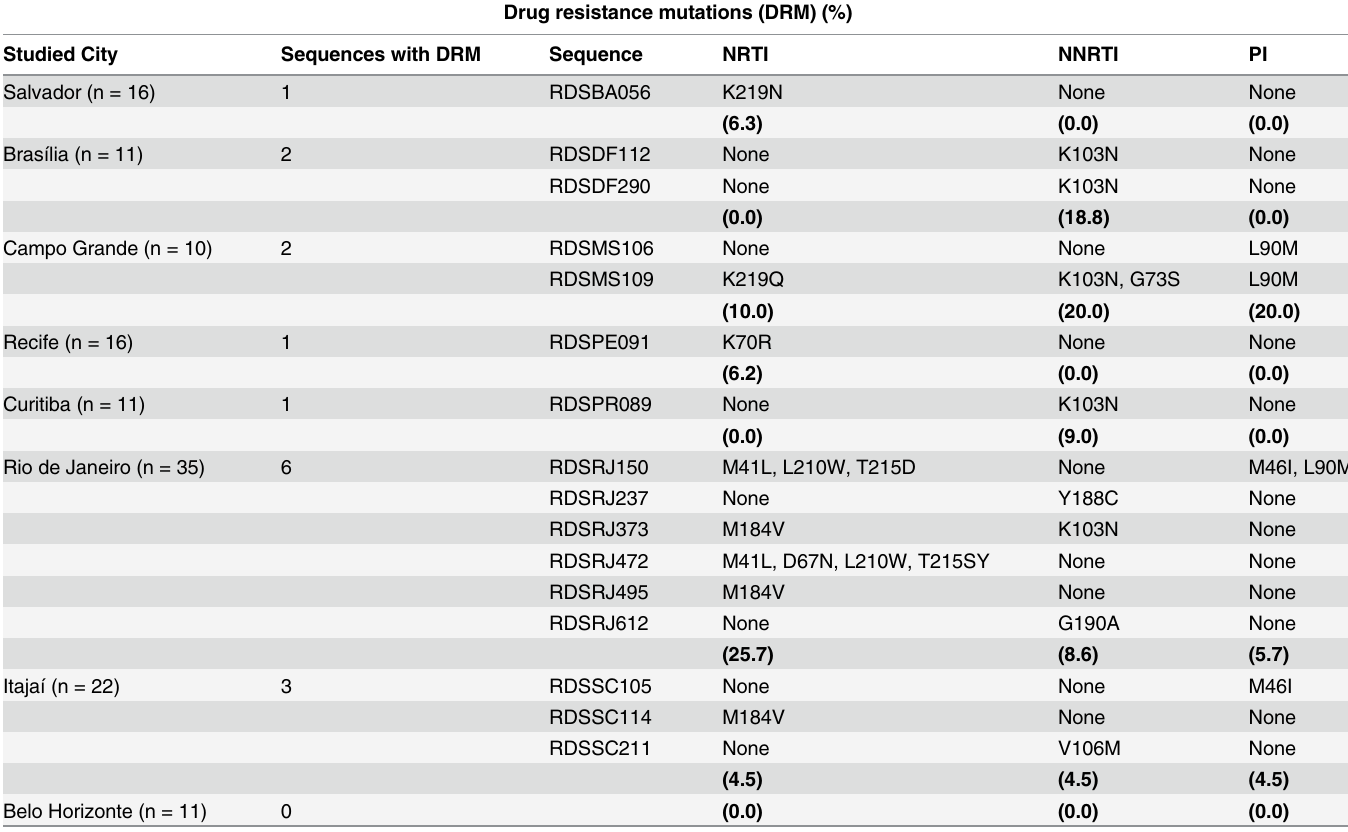
Table 2. List and frequency of drug resistance mutations detected in each studied city stratified by drug class. Drug resistance mutations (DRM)